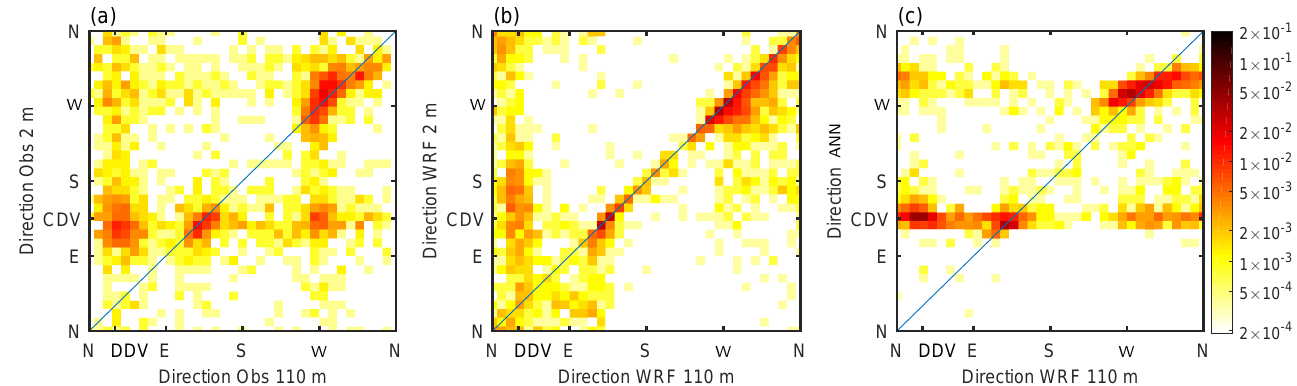
Figure 13. ( a , b ) Same as Figure 6. ( c ) Comparison of 110-m WRF wind direction and ANN wind